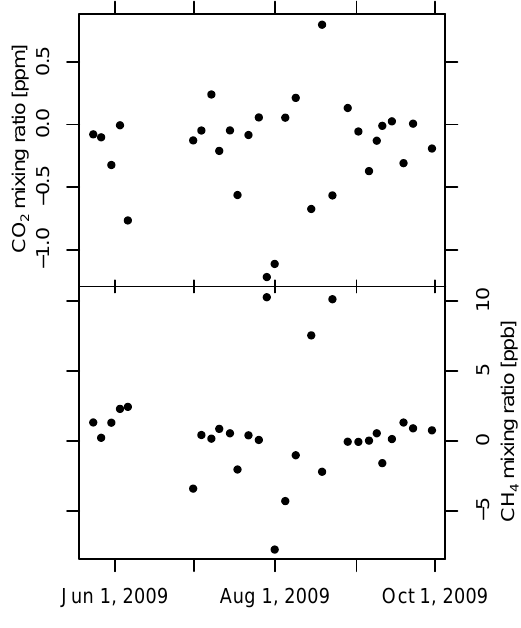
Fig. 6. Comparison of flask data with deconvolved CRDS data. Fig. 7. Time series of differences between flask and deconvolved in situ data.